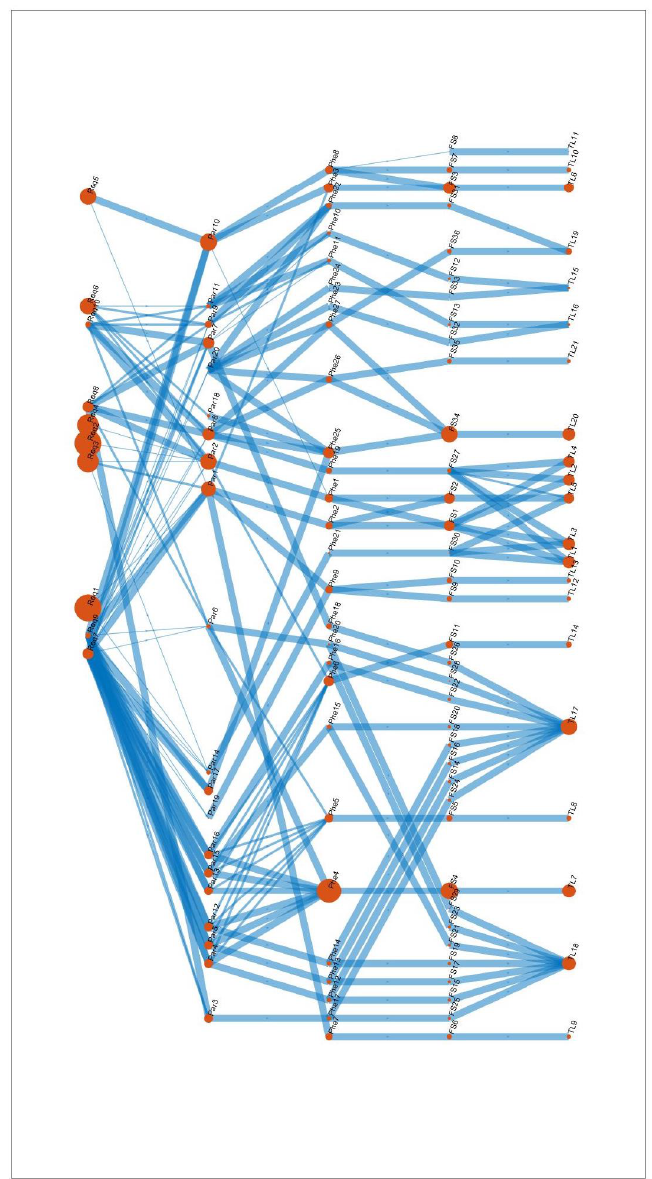
Figure 5. The network of connections between the Houses. The size of the red dots symbolizes the importance of the specific test loads, field stresses, phenomena, design parameters and requirements. The thickness of the lines represents the strength of assignments between each